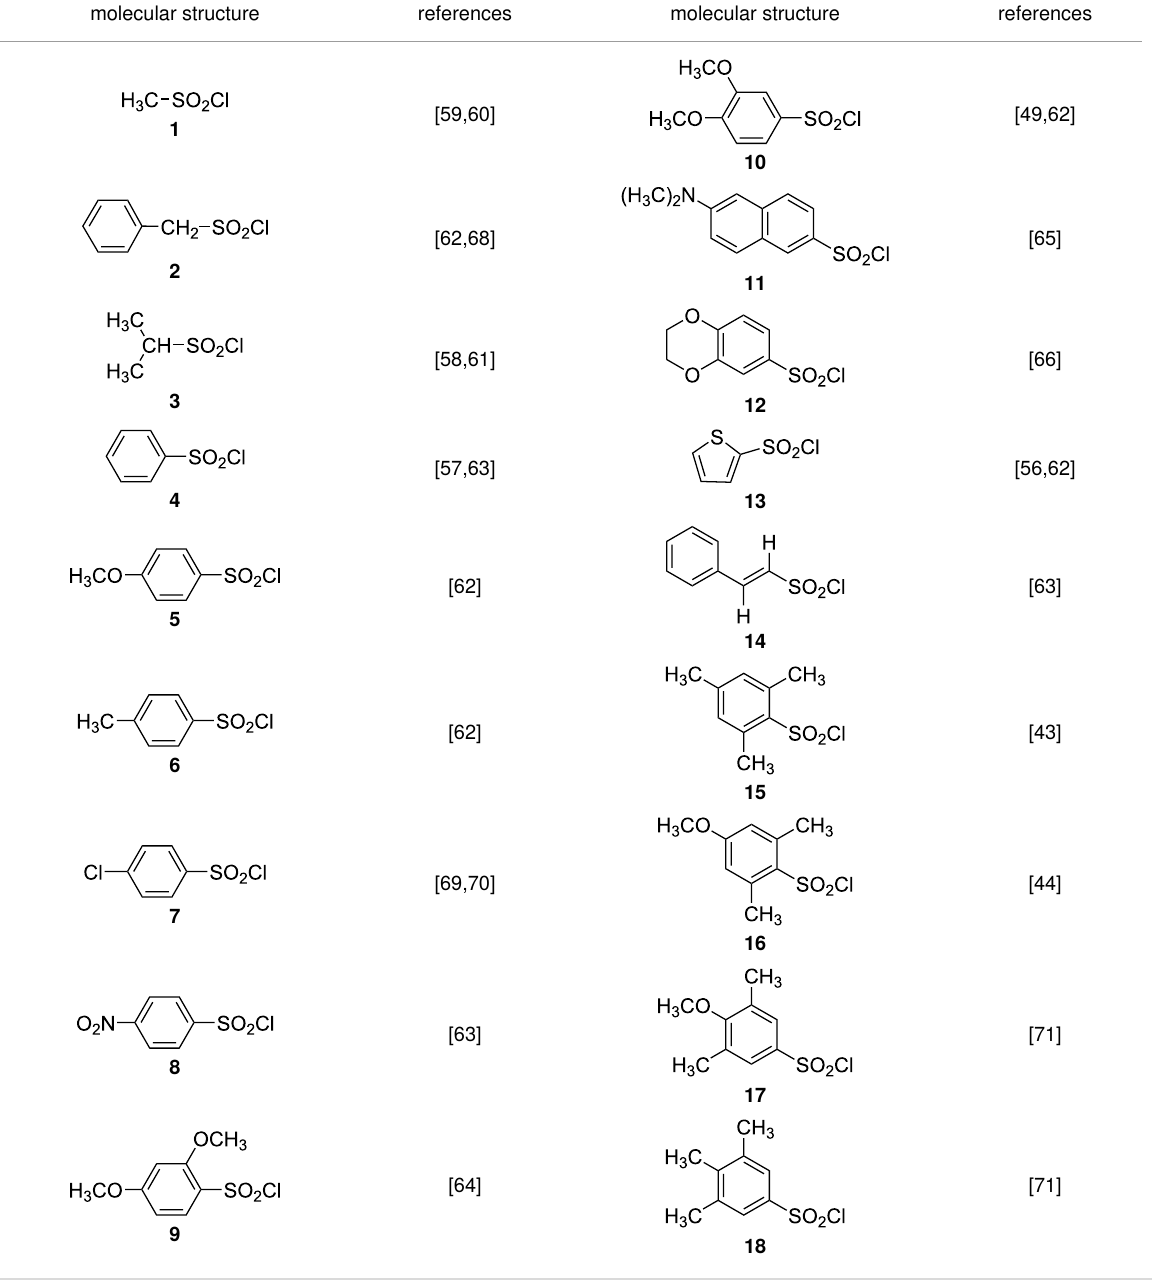
Table 1: Molecular structures of sulfonyl chlorides (ZSO 2 Cl) which have been studied kinetically in terms of the extended Grunwald–Winstein equa- tion and/or in terms of kinetic solvent isotope effects ( k sie values) with relevant references. molecular